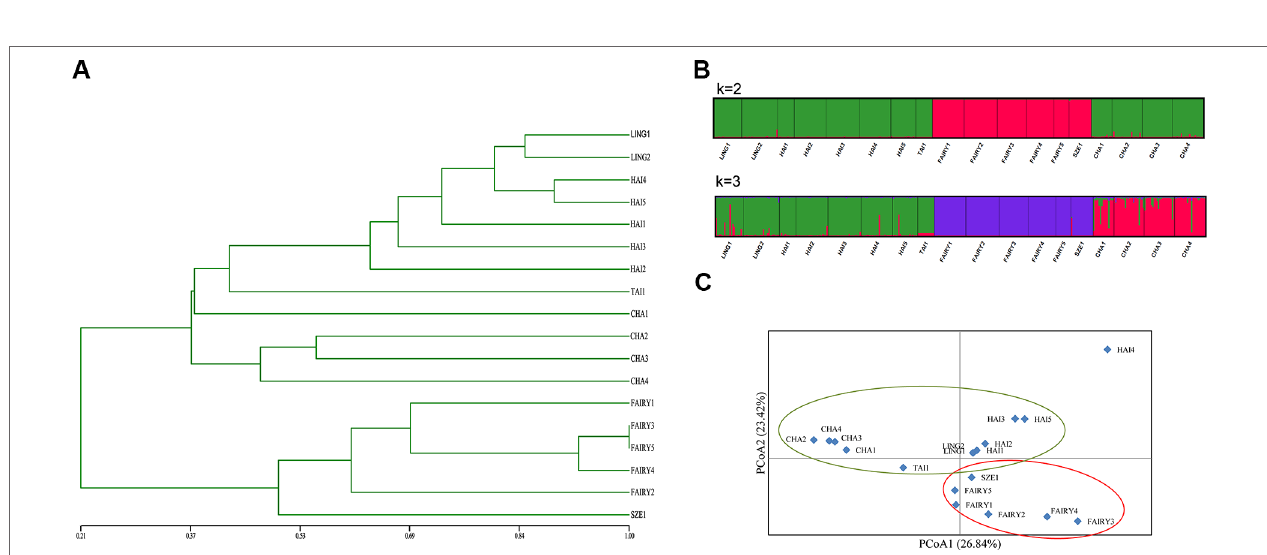
FIgUrE 3 | Clusters within the Cycas taiwaniana complex. (A) An unweighted pair-group method with arithmetic averages (UPGMA) phenogram. (B) Bayesian inferences ( K = 2 and K = 3). (C) Principal coordinates analysis (PCoA) of SSR phenotypes from 18 populations of 354 individuals of the C. taiwaniana complex. The percentage of variation attributed to each axis is